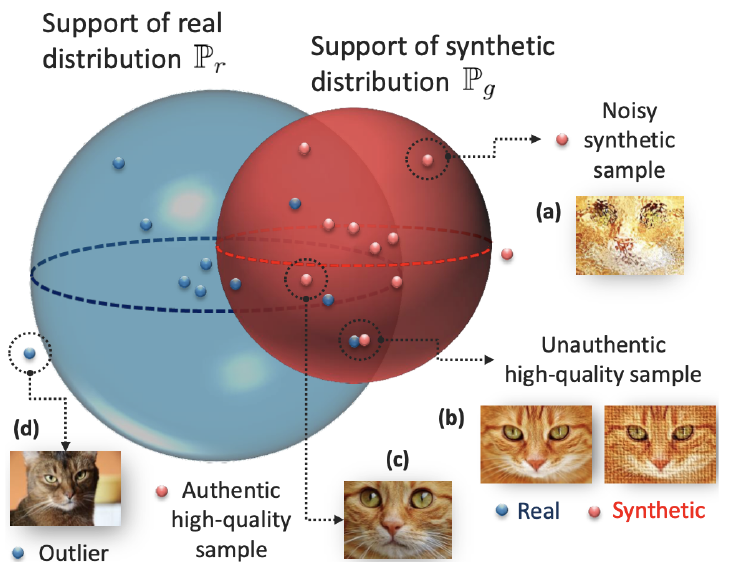
Figure 27. Representation of α -Precision, β -Recall, and Authenticity. The blue and red spheres correspond to the α - and β -supports of the real and the generated samples, respectively. Intuitively, these regions are “safe-zones” where points that lie outside the spheres are outliers, and points inside the spheres are “ordinary” samples. ( a ) Generated samples that lie outside the blue sphere are unrealistic. ( b ) Synthetic samples that are very close to real instances are inauthentic because they are almost exact copies of the real data. ( c ) Synthetic data points inside the blue sphere and without real data points near them are considered high-quality samples. ( d ) A data point outside the sphere is considered an outlier. Image retrieved from